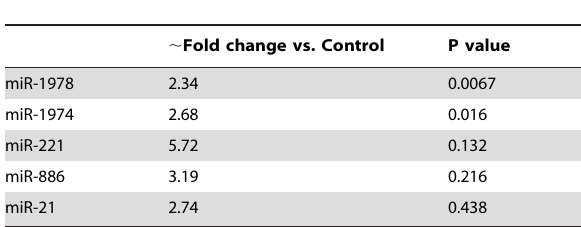
Table 2. Differentially expressed